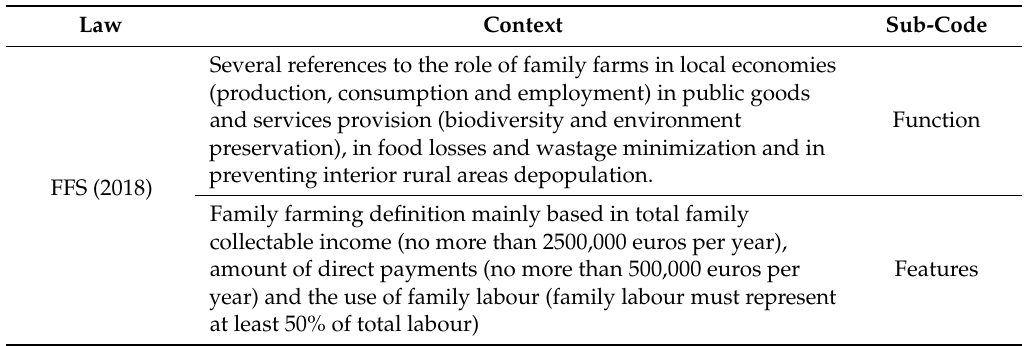
Table 6. Conceptual references to family farming in